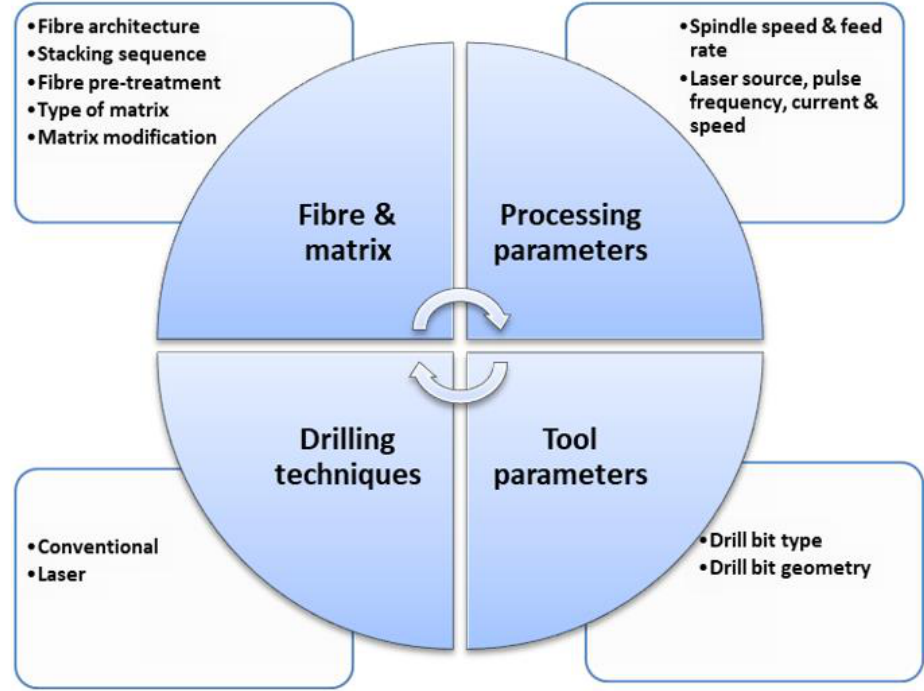
Figure 1. Parameters influencing the drilling characteristics of polymer biocomposites.